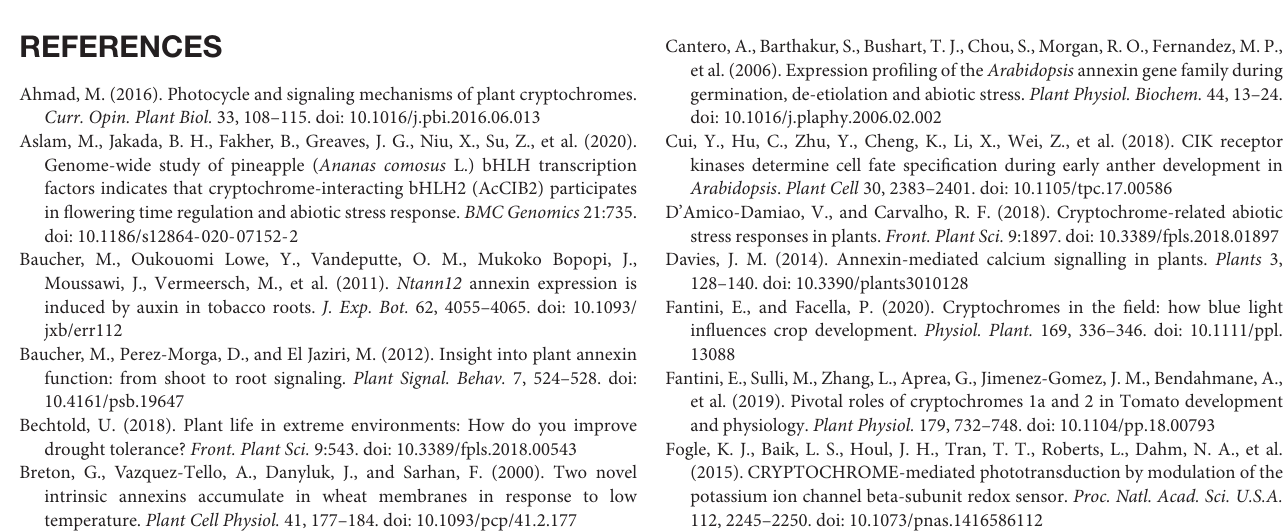
Supplementary Figure 1 | The ratio of plants in response to mannitol treatment by regulating subcellular localization. Subcellular localization of AtANN2-GFP and AtANN3-GFP fusion proteins using the transgenic lines. 10-day-old plants under different photoperiods were treated with 300 mM mannitol for 5 min, and GFP signals were observed under a confocal laser-scanning microscope. At least 10 plants were counted in each treatment. Plasma membrane signal (%) = number of plants responding to mannitol treatment/number of total plants. Supplementary Figure 2 | Regulation of the subcellular localization of AtANN2 and AtANN3 in response to mannitol treatment under different photoperiods. (A) Subcellular localization of the AtANN2-GFP and AtANN3-GFP fusion proteins in response to mannitol treatment for 0, 5, 10, 30, and 60 min using leaf cell protoplasts of Col-0 plants grown under different photoperiodic conditions. Scale bar = 20 µ m. (B) Subcellular localization of AtANN2-GFP and AtANN3-GFP fusion proteins using the transgenic lines. 10-day-old plants under different photoperiod were treated with 300 mM mannitol for 5 min and GFP signals were observed under a confocal laser-scanning microscope. Scale bar = 20 µ m. Supplementary Figure 3 | AtCRY2 regulated subcellular location of AtANN2 and AtANN3 in response to mannitol treatment. (A) Subcellular localization of the AtANN2-GFP and AtANN3-GFP fusion proteins in response to mannitol treatment for 0, 5, 10, 30, and 60 min using leaf cell protoplasts of AtCRY2-OE plants grown under different photoperiodic conditions. Scale bar = 20 µ m. (B) Subcellular localization of AtANN2-GFP and AtANN3-GFP fusion proteins using the transgenic lines in the AtCRY2-OE background subjected to treatment the same as Supplementary Figure 2B